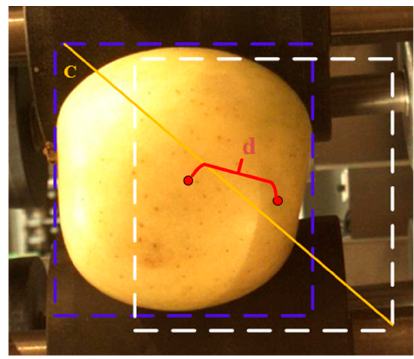
Figure 10. DIoU schematic.